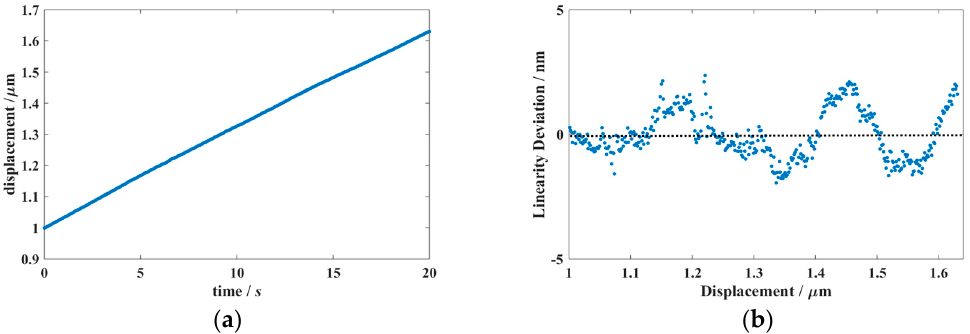
Figure 7. ( a ) Displacement as a function of time during cooling down of the aluminum tube. ( b ) The linearity deviation from a second-order fit.